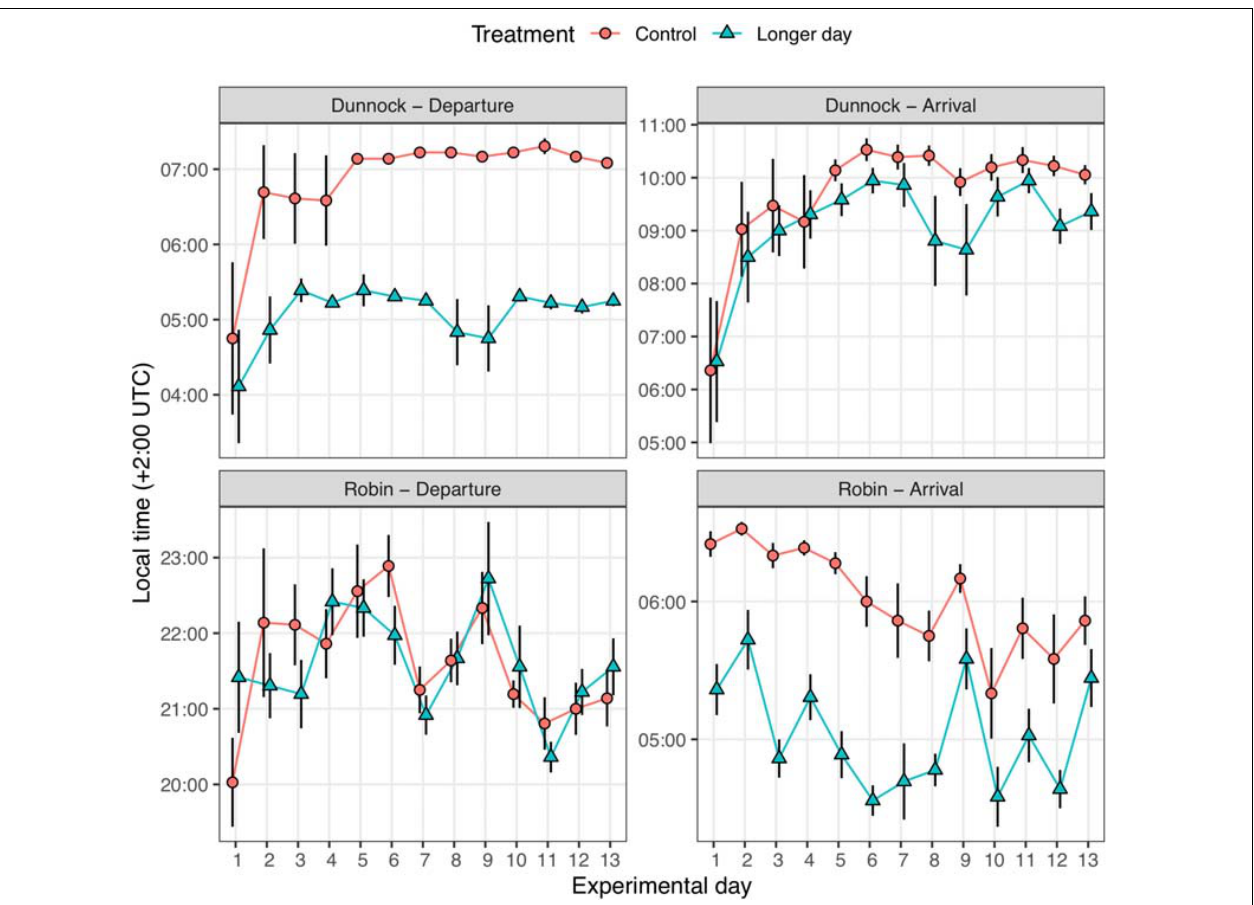
FIGURE 3 | Time ( ± SE) of migratory departure and arrival for first-year migratory dunnocks ( Prunella modularis ) and European robins ( Erithacus rubecula ) monitored under local daylength timing (Control) and 2 h experimentally advanced early sunrise (Longer day) conditions ( n = 12 for each treatment group; n = 24 for each species). For information on categories, see main